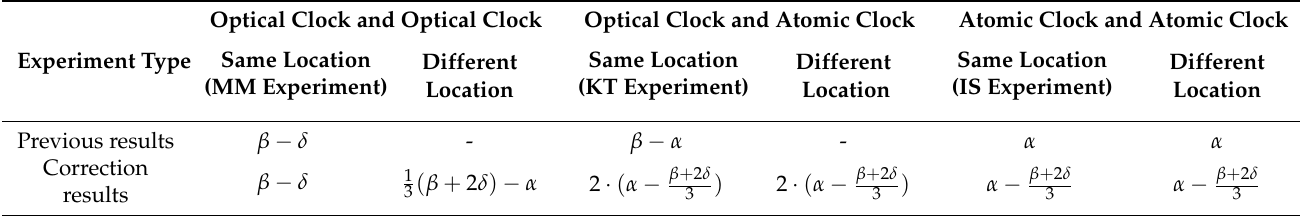
Table 2. Comparison of the previous results and current revised results of various